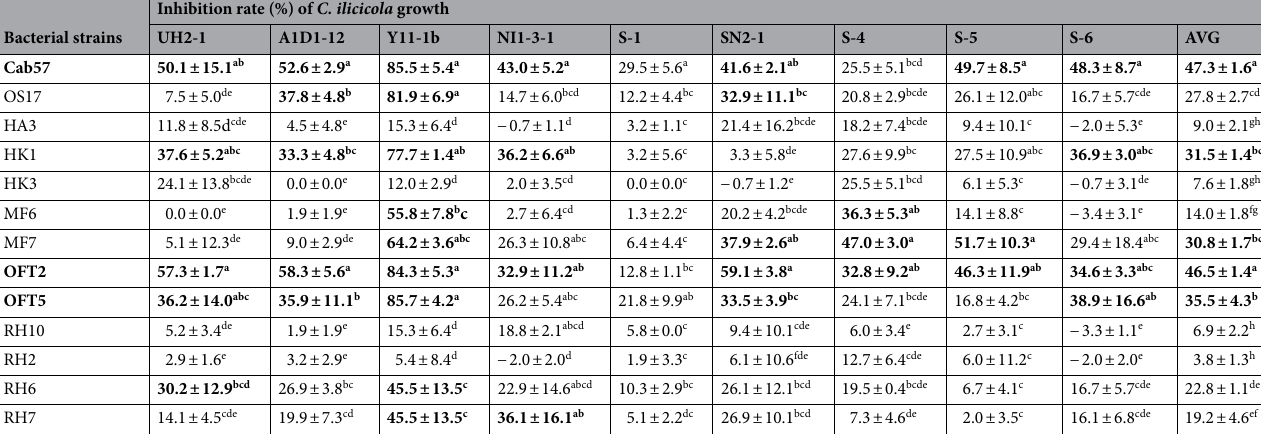
Table 2. Antifungal effects of bacterial VOCs on the mycelial growth of nine different Calonectria ilicicola isolates in the double-plate chamber test. Different letters indicate significant differences at the 5% level (Tukey’s Honest Significant Difference (HSD) test). Inhibition rates ≥ 30%, and the three Pseudomonas strains with high antifungal activity (Cab57, OFT2 and OFT3) are highlighted by bold fonts.